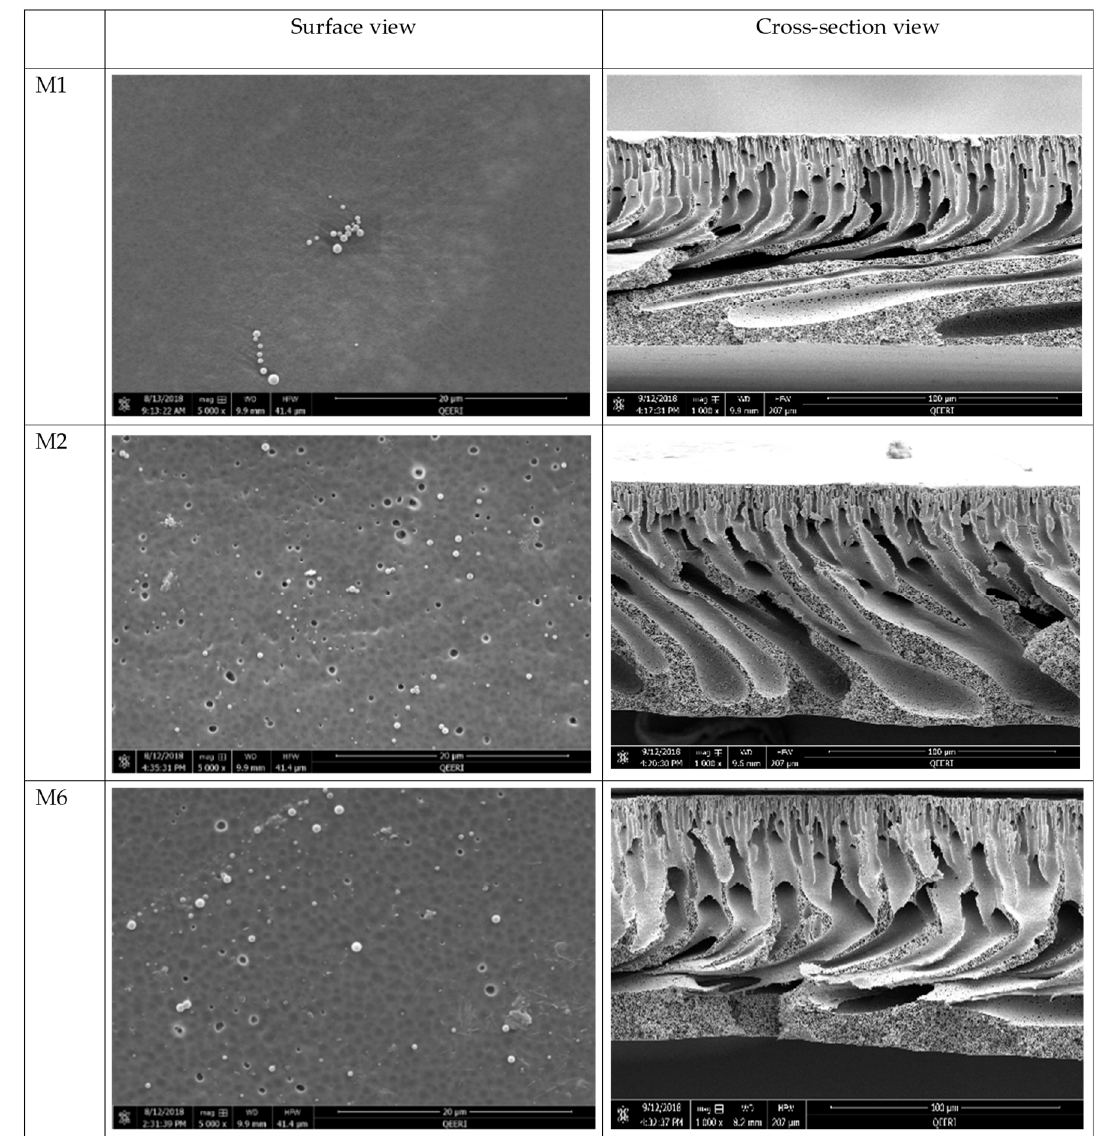
Figure 4. FESEM surface and cross-section images of selected synthesized membranes (M1, M2, and M6).